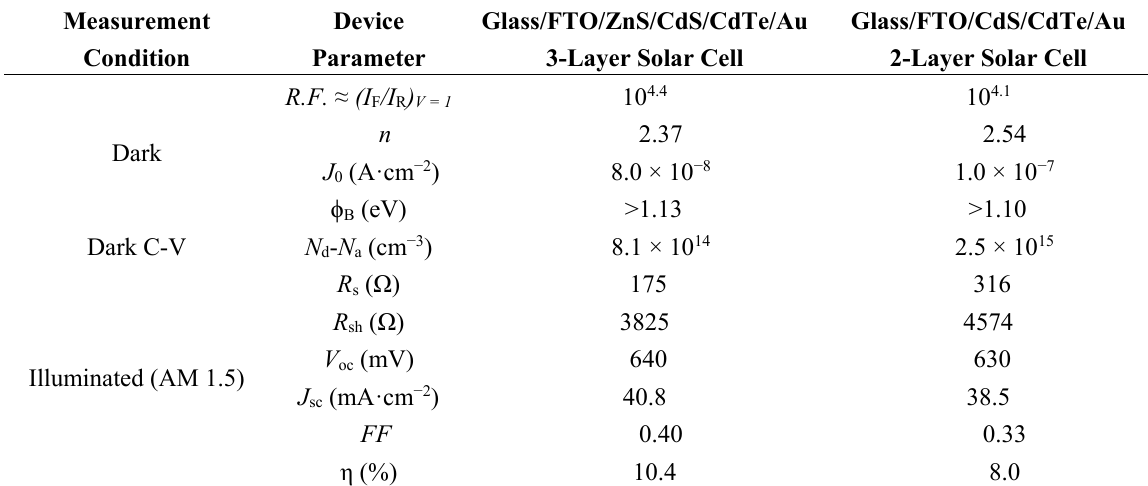
Figure 8. Linear-linear dark current density-voltage graph for ( a ) glass/FTO/ZnS/CdS/CdTe/Au 3-layer solar cell and ( b ) glass/FTO/CdS/CdTe/Au 2-layer solar cell, under forward and reverse bias conditions. Table 1. Summary of device parameters for the two solar cell structures for comparison. Measurement Device Condition Parameter 3-Layer Solar